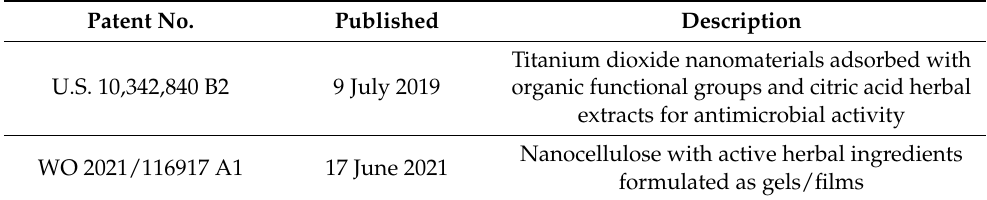
Table 5. A snapshot of patents highlighting the use of nanotechnology in herbal dentistry. Patent